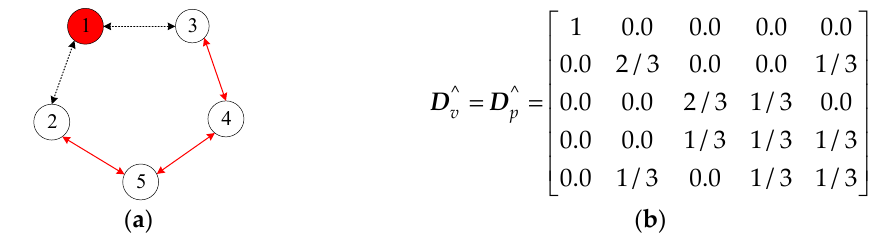
Figure 13. The remaining topology and the corresponding matrix D ˆ . ( a ) the remaining topology; ( b ) the corresponding matrix.